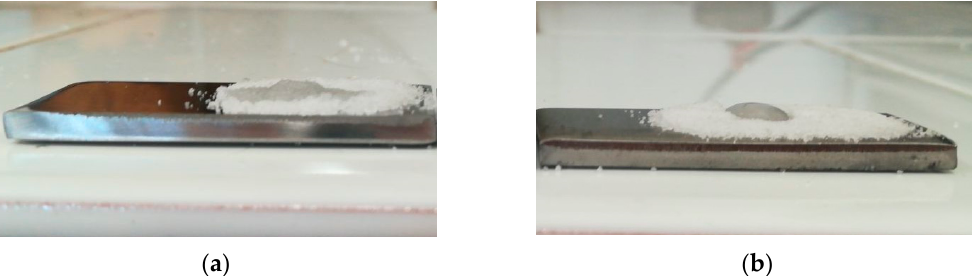
Figure 4. Self-cleaning test of the SS samples with ( a ) mirror-like and ( b ) 2B G320 surface finishing before electrodeposition process.